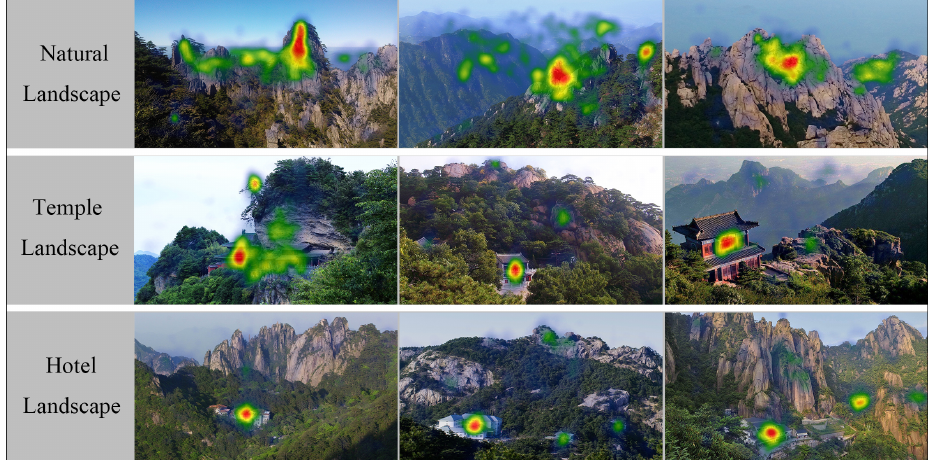
Figure 3. Heat maps of landscape